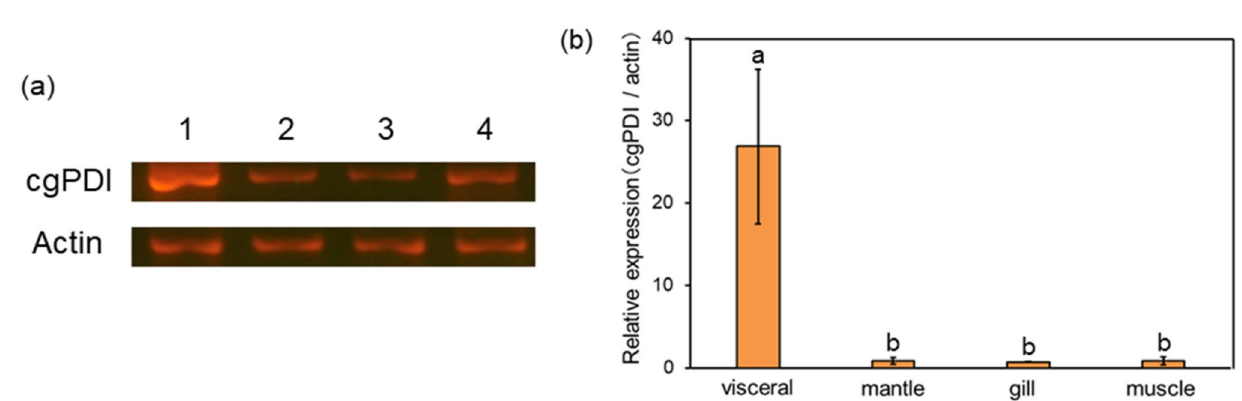
Figure 4. Tissue-specific expression of cgPDI by RT-PCR analysis. ( a ) cDNAs prepared from the visceral (lane 1), the mantle (lane 2), the gill (lane 3), the muscle (lane 4) were separately subjected to RT-PCR, and the products were analyzed on an agarose gel. The sequences of primers were described in Table 1. Actin as control. ( b ) Relative expression analyzed for relative quantification using ImageJ band density analysis. Error bars represent the standard deviation (n = 6); mean values with different lower-case letters (e.g., a , b ) are statistically different from one another (one-way analysis of variance, ρ < 0.05). The data was analyzed using IBM SPSS software (version 18.0; SPSS